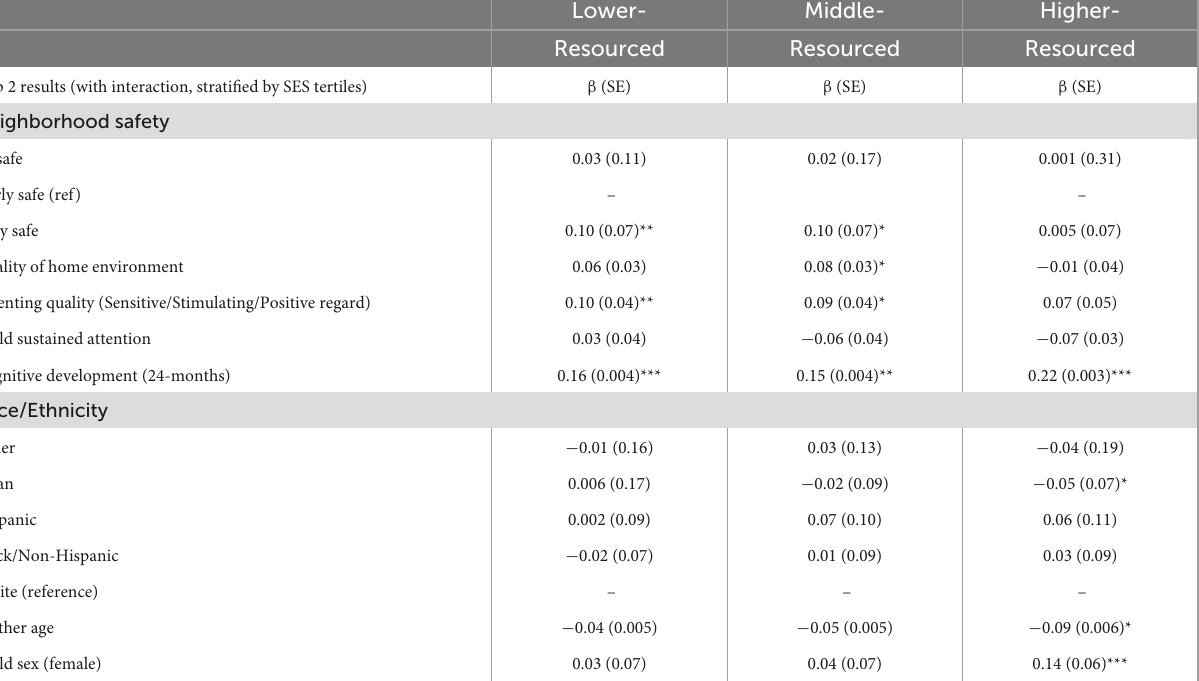
TABLE 4 Adjusted associations of neighborhood safety, parenting, quality of the home environment and curiosity at kindergarten, stratified by socioeconomic status (SES) tertiles.